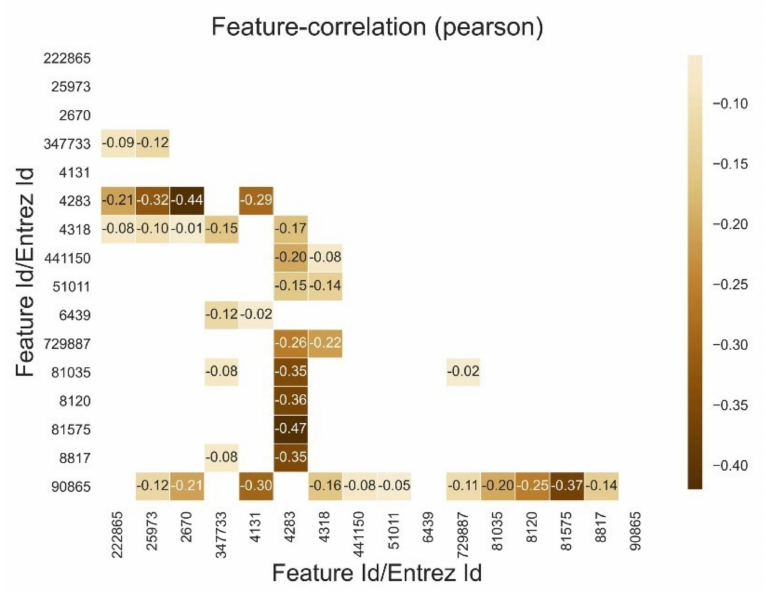
Figure 12. Negative Feature Correlation Heat